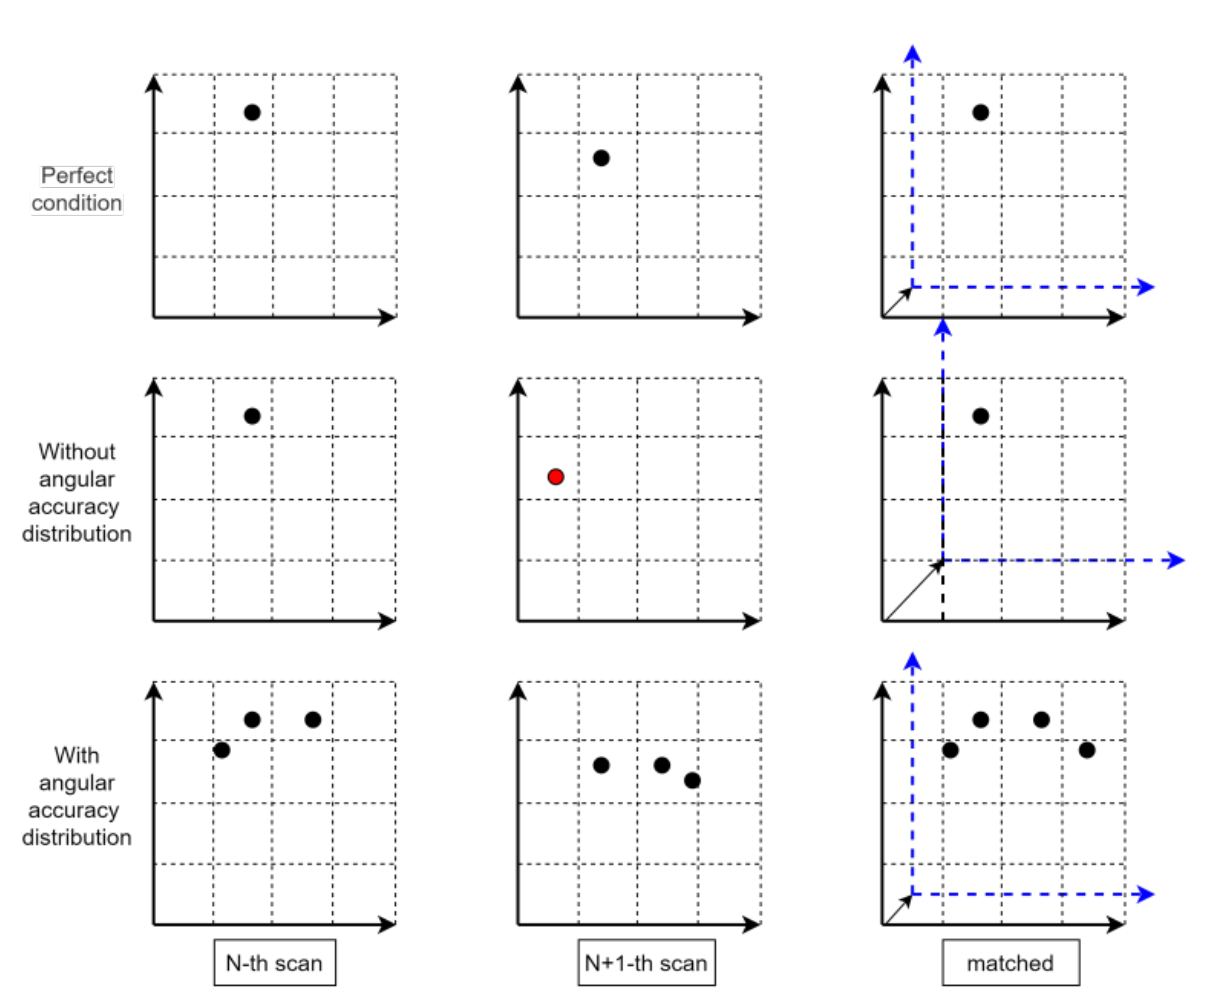
Figure 9. Point cloud matching diagram.